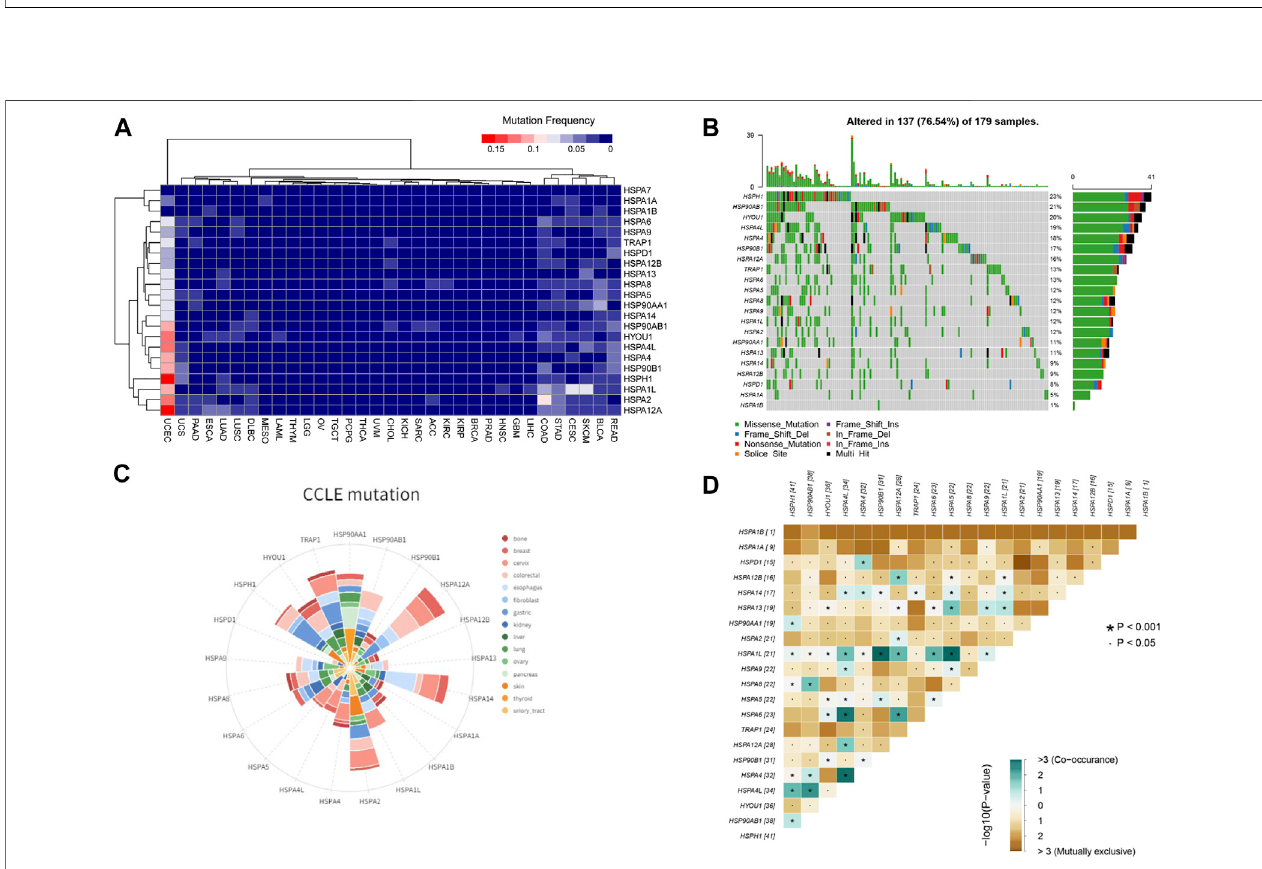
FIGURE 6 | HSP mutations at tissue and cell level across different cancer types. (A) Mutation frequency of HSPs in tissues across different cancer types. (B) Oncoplot for HSPs in UCEC. HSPH1 has the most frequent mutation in UCEC. UCEC, uterine corpus endometrial carcinoma. (C) Mutation status of HSPs in different cancercelllinesfromCCLEdatabase. (D) CorrelationamongHSPmutationsinUCEC.Bluecolorrepresentsco-occurancemutationandbrowncolordisplayedmutually exclusive.Thenumberrepresentssamplesizesofmutation.UCEC,uterinecorpusendometrialcarcinoma.CCLE,CancerCellLineEncyclopedia.HSP,heatshock protein. UCEC, uterine corpus endometrial